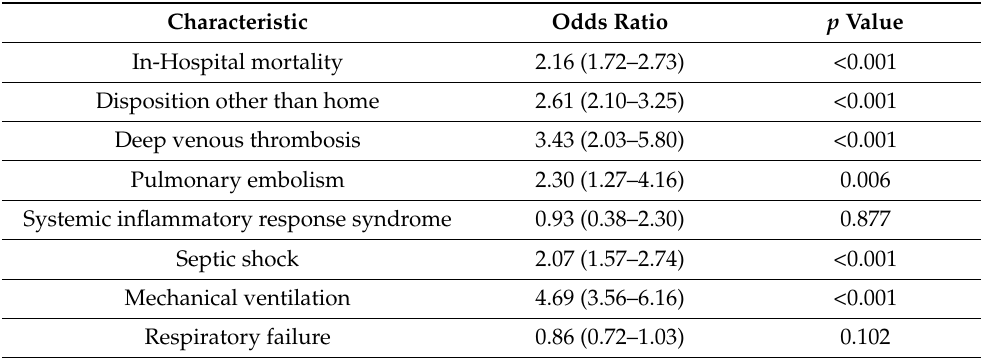
Table 2. Conditional logistic regression of hospital outcomes between COVID-19 hospitalizations with AIS and COVID-19 hospitalizations without AIS.